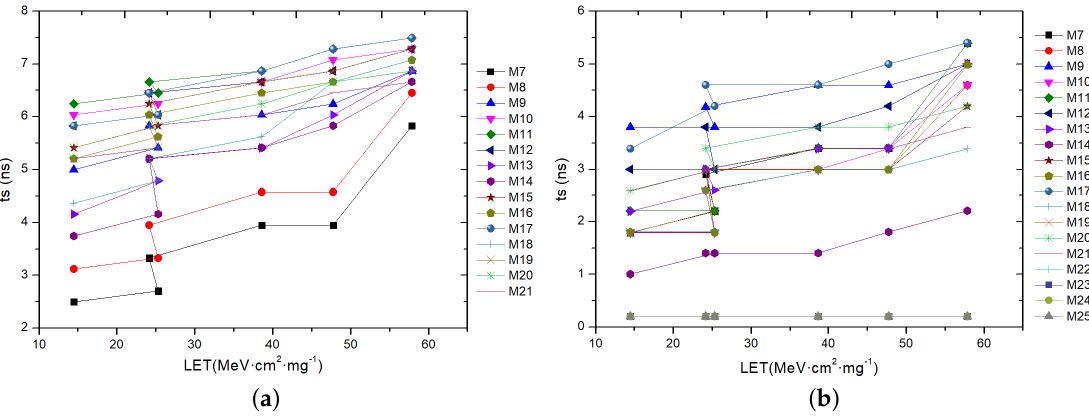
Figure 12. INP output recovery time of the FD2. ( a ) Before RHBD; ( b ) After